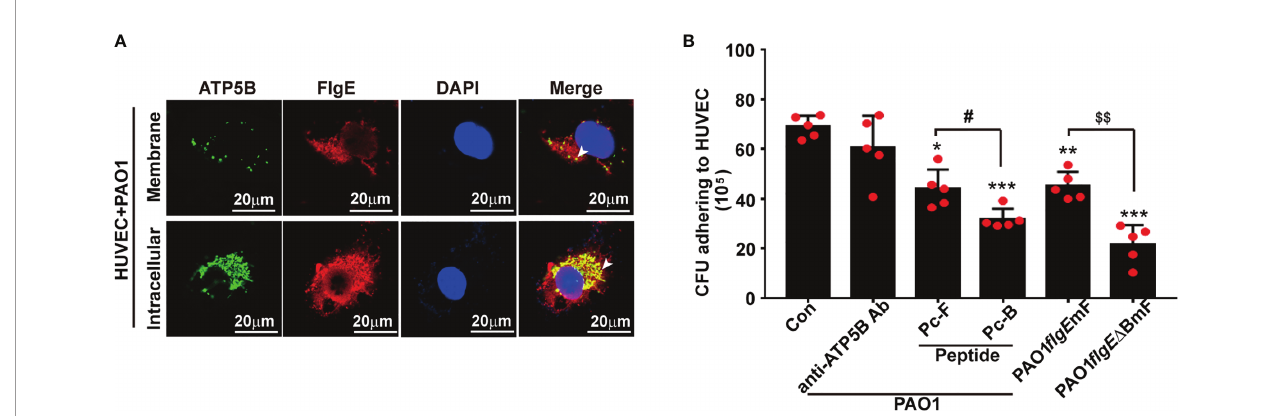
FIGURE 8 | Observation and measurement of PAO1 adhesion onto and engulfment by HUVECs. (A) Immuno fl uorescence staining of FlgE and ATP5B protein in PAO1-infected HUVECs was performed after coculture of PAO1 with HUVECs for 1 h at 37°C. HUVECs were either permeabilized for intracellular staining or not permeabilized for staining surface components. FlgE was stained with Pc-FlgE Ab (1 m g/ml) in combination with anti-rabbit Alexa-Flour 555 (red), and ATP5B with murine anti-ATP5B antibody (1 m g/ml) in combination with anti-mouse Alexa-Flour 488 (green). White arrowheads point at colocalization of FlgE and ATP5B in HUVECs. (B) For measuring the effect of peptides or antibodies on PAO1 – HUVEC adhesion, HUVEC monolayers grown in plates were incubated with anti-ATP5B antibodies (50 m g/ml) or peptides Pc-B/Pc-F (100 m M) for 1 h Then 500 m l of 10 8 /ml of wild-type PAO1 or mutant PAO1/ fl gEmF or PAO1/ fl gE △ BmF strains was added and incubated for another 2 h After careful washing, the culture was harvested into lysis buffer, and the lysates were serially diluted and spread on LB agar plates for 20-h culture. The colonies were counted by the naked eyes. Data are shown as mean ± SD. * p < 0.05, ** p < 0.01, *** p < 0.001 vs . Con. # or $ p < 0.05 as labeled. All by one-way ANOVA test. HUVECs, human umbilical vein endothelial cells; LB, Luria